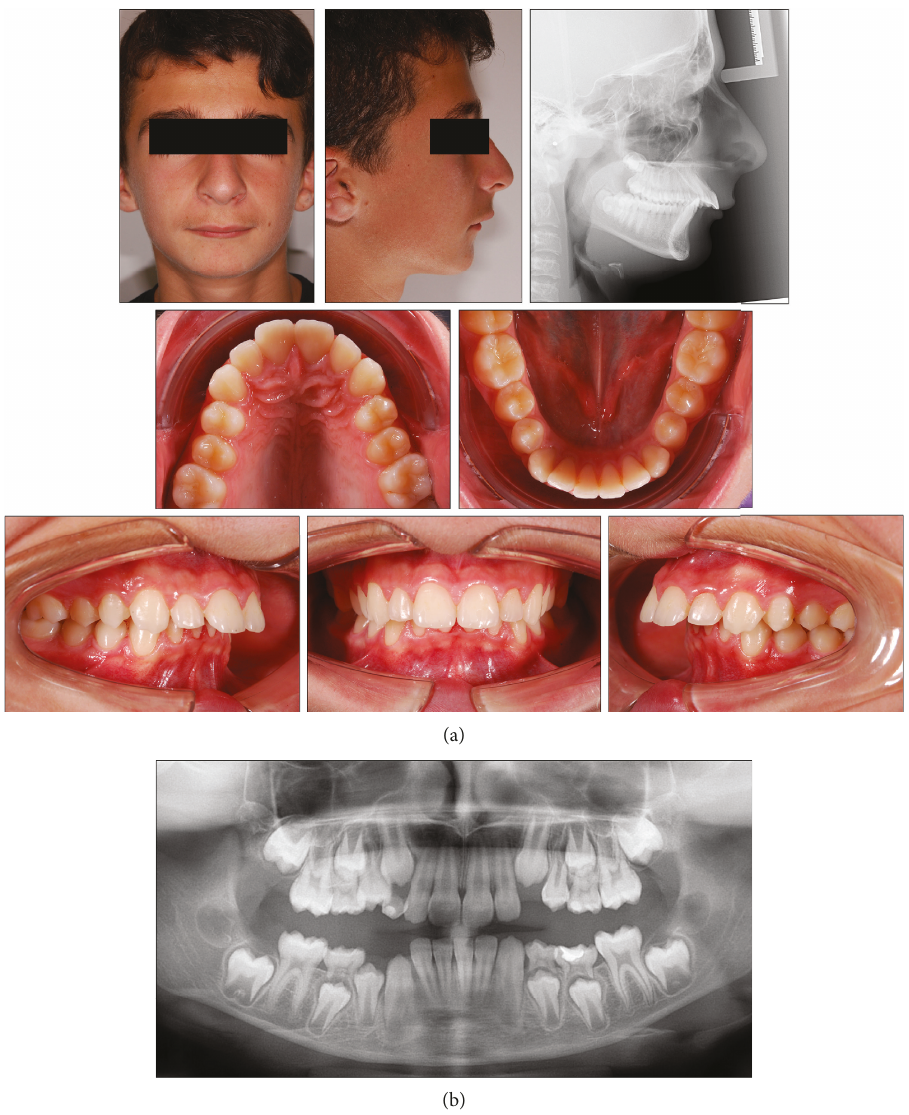
Figure 2: Case 1. (a) 9-year and 10-month-old male patient with skeletal Class II malocclusion, increased overjet, and overbite before treatment. (b) Panoramic radiograph taken at fi rst visit when the patients was 9 years